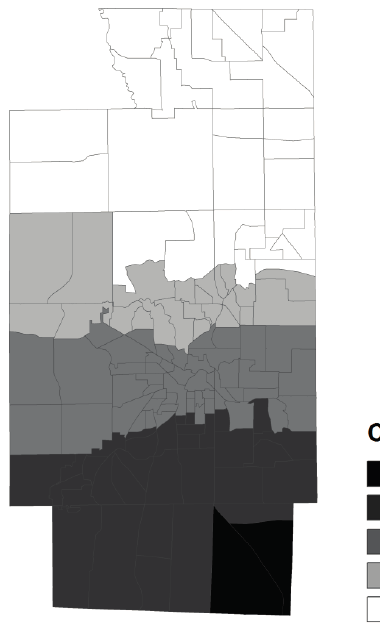
Figure 3. Spatial patterns of regression coefficients for unemployment ratios. ( a ) Census Tracts; ( b ) Census Block